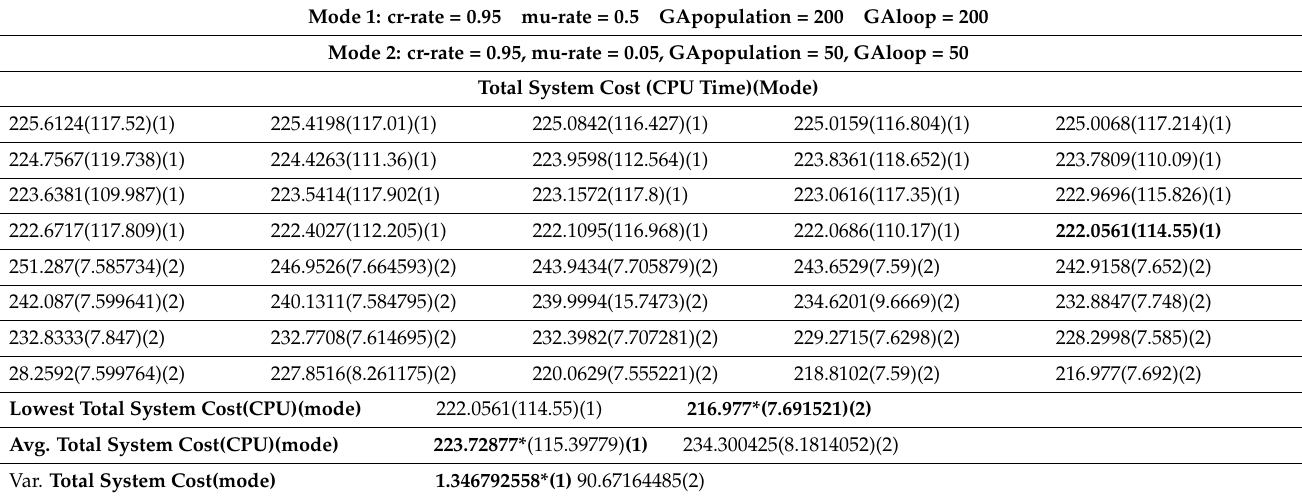
Table 44. Optimal Solutions obtained by mode 2 of MRAH–MGA for the for the n -stage mixed sys- tem.